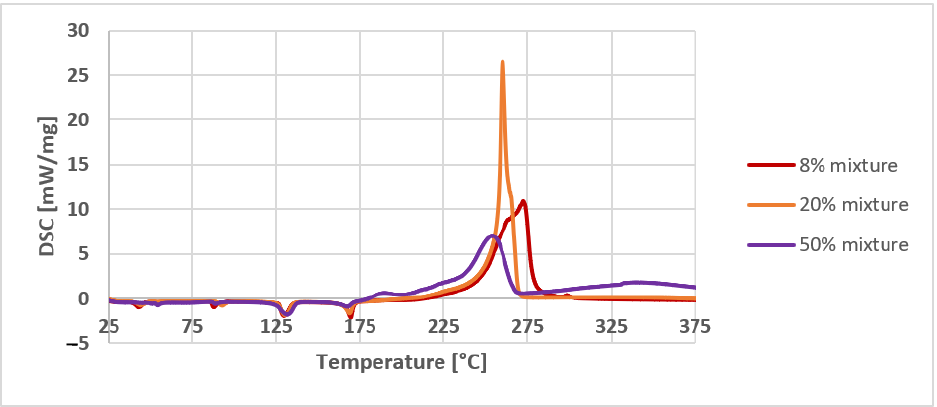
Figure 3. DSC analysis showing the influence of AN and PE mixture composition on the mixture’s thermal properties, heat rate 10 °C/min.